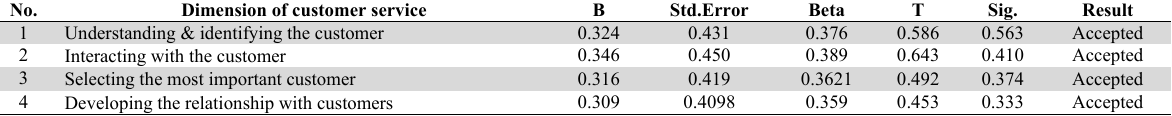
Correlation of the dimensions of CRM variables in travel & tourism organizations with retention the customers.